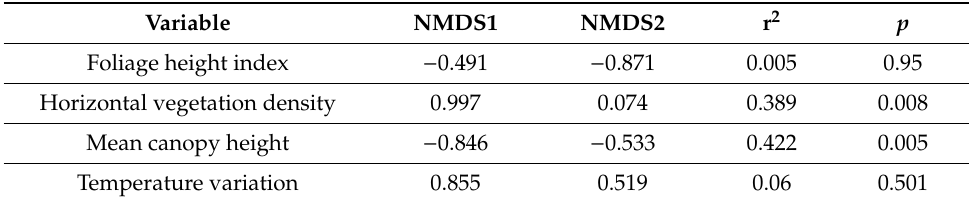
Figure 4. Non-metric multidimensional scaling (NMDS) with ordination based on Bray–Curtis dissimilarities to compare forest interiors and forest edges by site category. Triangles represent forest interiors and circles represent forest edges. Black-filled symbols represent vegetation types at papaya sites and empty symbols represent vegetation types at pasture sites. Vectors represent explanatory variables and their lengths represent the strengths of their relationship with NMDS axis. We excluded agricultural land from this analysis because vegetation measurements were only made at forest interiors and forest edges. Table 2. Correlation values (r 2 ) between the explanatory variables and the non-metric multidimensional scaling (NMDS) axis that compares forest interiors and forest edges by site category in Figure